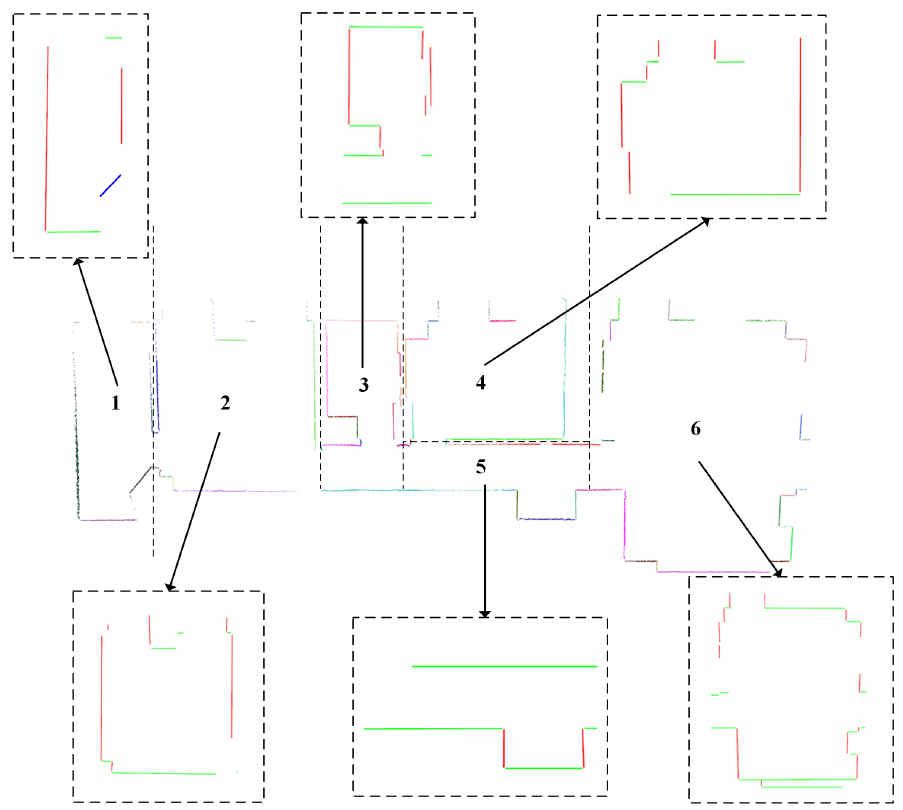
Figure 13. The types of linear primitives in sub-contours: vertical primitives (red), horizontal primitives (green), and arbitrary primitives (blue). 1–6 indicate the sub-floorplans in the 2D